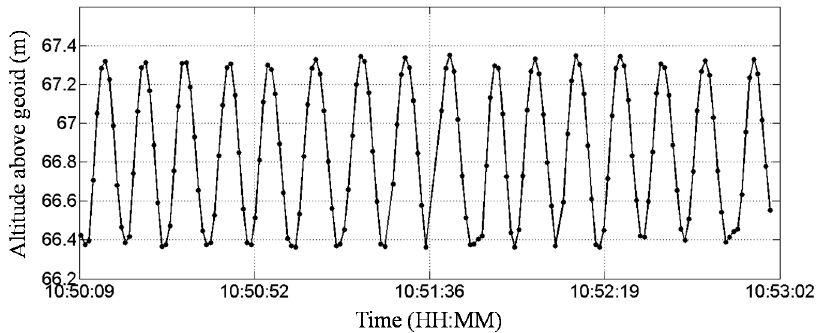
Figure 3. Altitude of the GNSS receiver above the geoid in dynamic test.